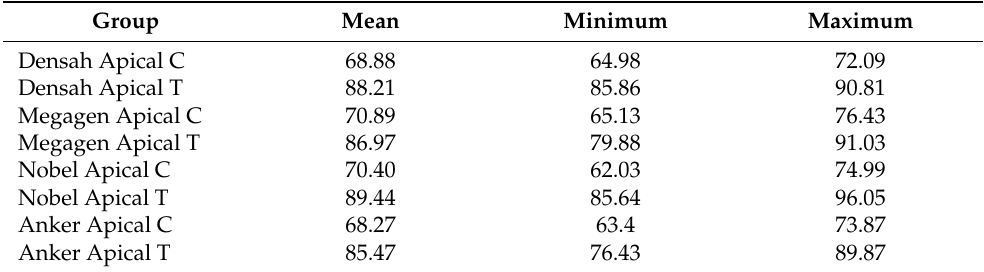
Table 6. Descriptive statistics. Percentage of relative bone condensation at the apical region.